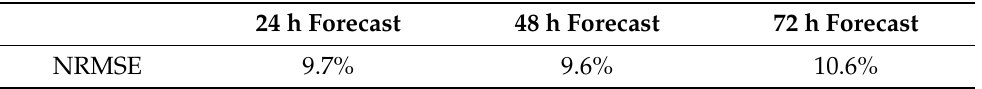
Table 9. Comparison of PV generation prediction error according to weather data forecasting